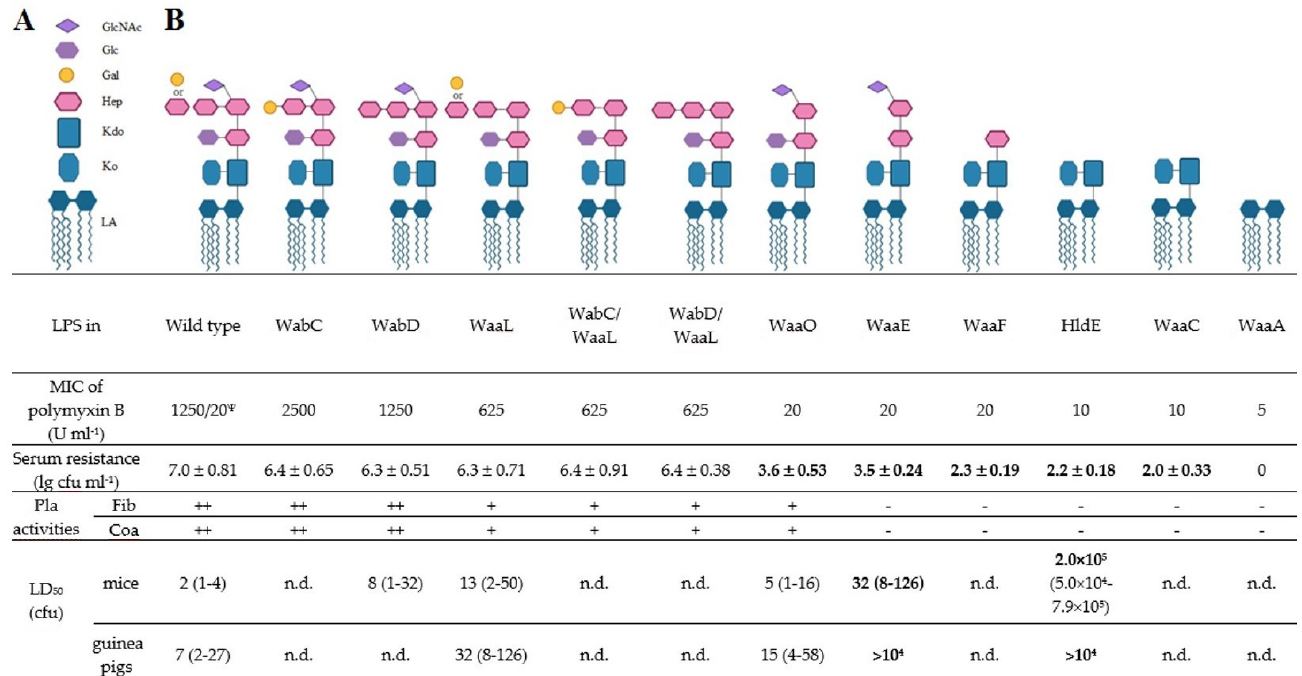
Figure 3. Biological properties of wild-type Y. pestis strain 231 and derived LPS mutants. ( A ) Key to LPS moieties. ( B ) LPS core structures of Y. pestis 231 and its isogenic mutants. Data are a summary of previous work on LPS of Y. pestis 231 [35] LA and wild-type lipid A; when both are present, DD -HepIV and Gal alternate at the non-reducing end. In all strains, terminal Ko is partially replaced with terminal Kdo. Significant changes in biological properties are indicated in bold face. MIC, minimal inhibitory concentration; cfu, colony forming unit; /20 Ψ , MIC at 6 ◦ C; n.d., not determined; Fib, fibrinolytic activity; a positive fibrinolysis test “++” was represented by complete clot lysis; a positive test “+” was represented by any degree of lysis; a negative test “ − ” was represented by a solid clot; CoA, coagulase activity; a positive coagulase test “++” was represented by a solid clot; a positive test “+” was represented by any degree of incomplete clotting (from a loose clot to a solid clot in liquid plasma); a negative test “ − ” was represented by the absence of